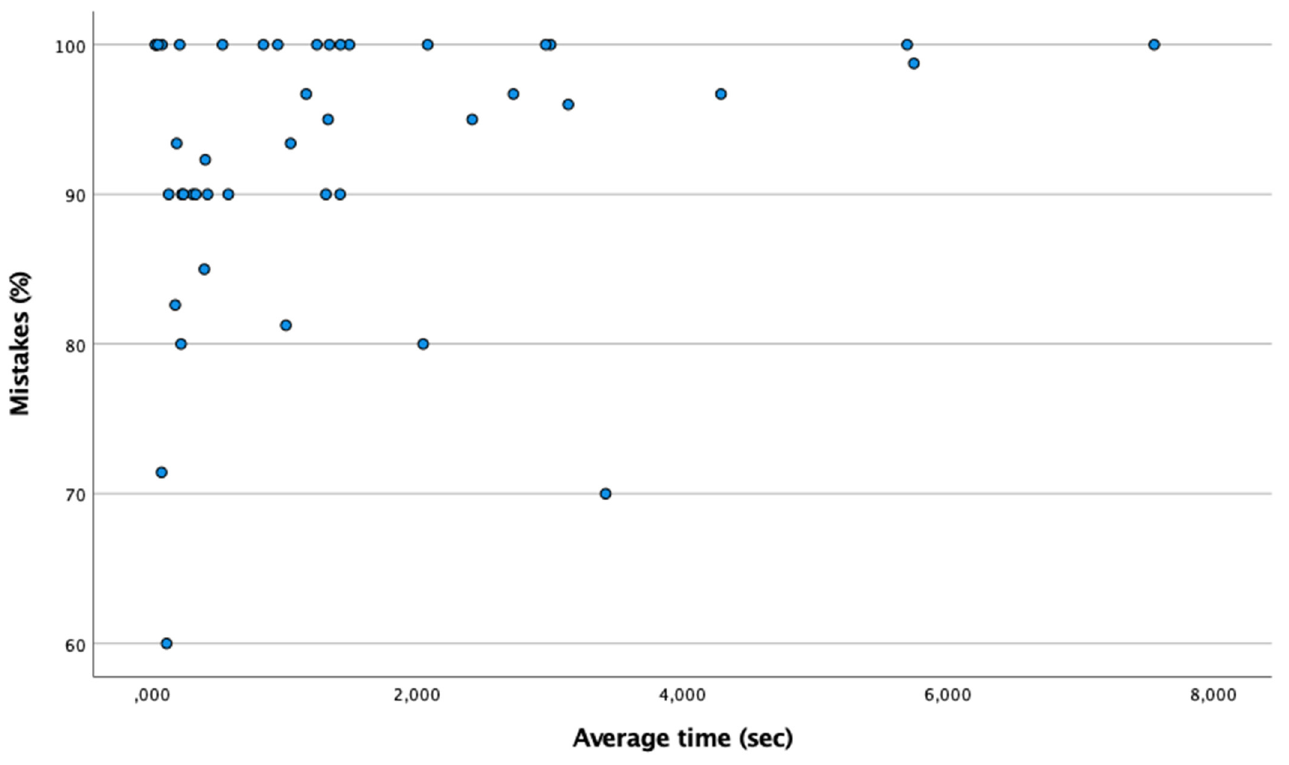
Figure 2. Absence of relationship between the percentage of failures and the mean time in the anticipation time test.